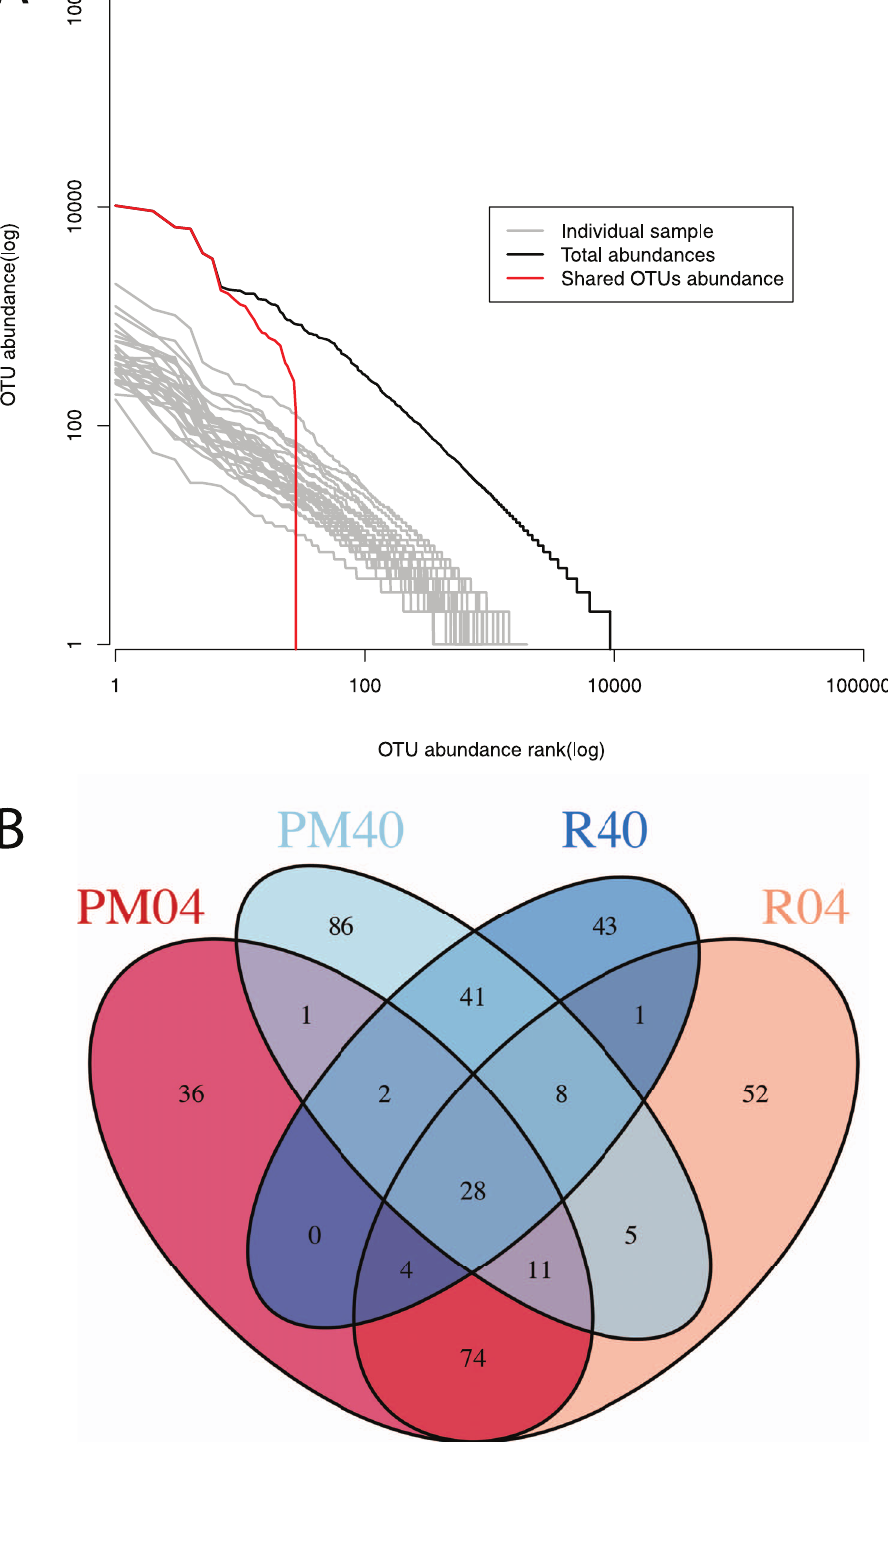
Figure 3. Shared OTUs between all samples. A) Rank abundance curves for all samples at the 97% sequence similarity cut-off. Black depicts the rank abundance curve for all OTUs in all samples. Red indicates the rank abundance curve for the 28 OTUs shared across all samples. In grey the rank